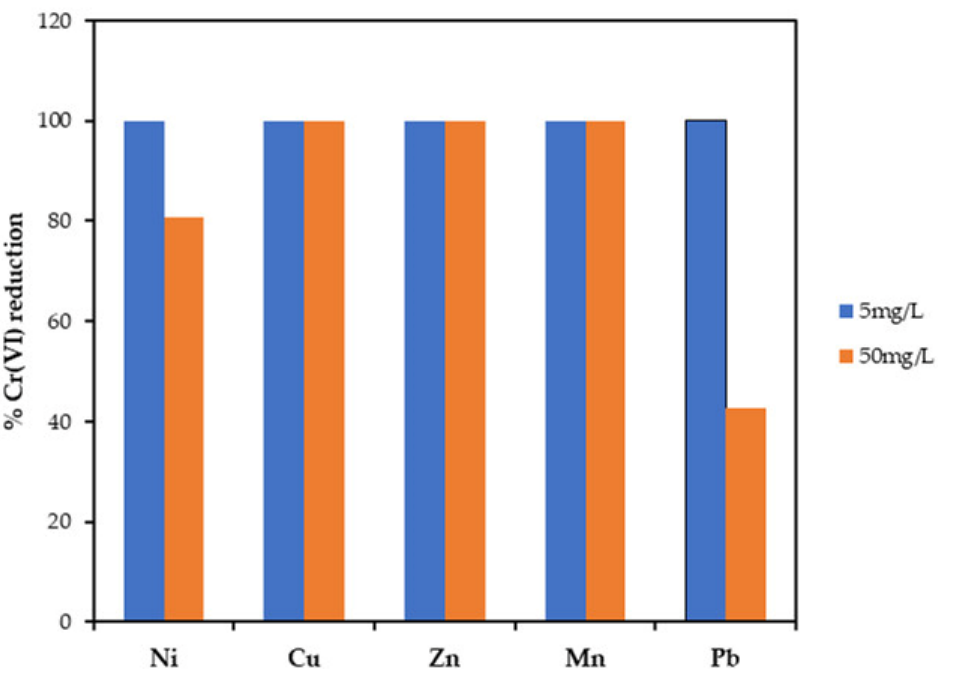
Figure 5. The effect of 5 and 50 mg/L of various heavy metals on reduction of 50 mg/L Cr(VI) by wastewater sludge bacteria consortia.